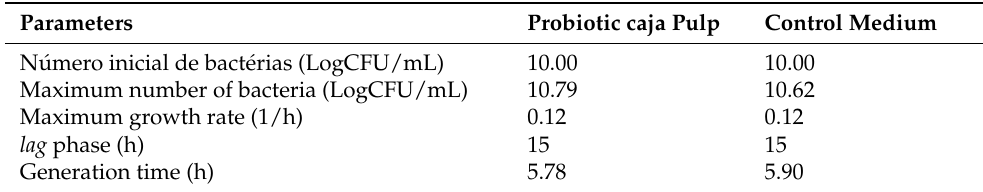
Table 1. Biological parameters of the growth of Bifidobacterium animalis ssp. lactis in caja pulp and the control medium (MRS